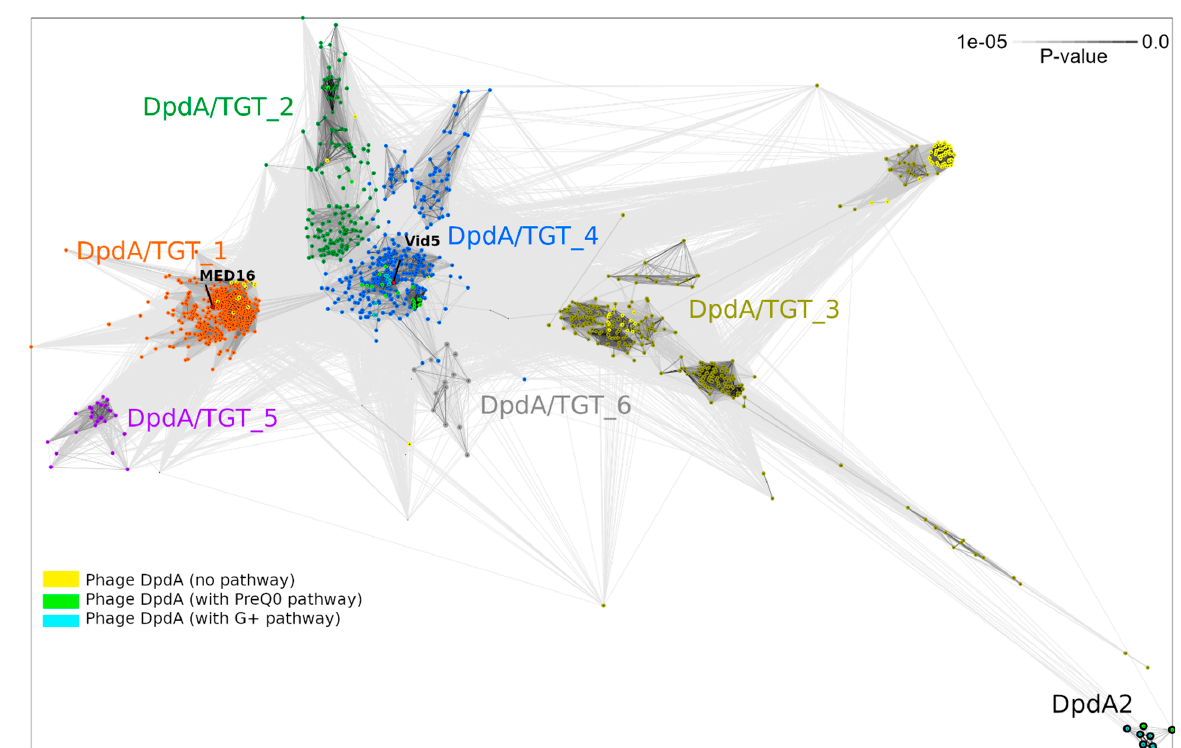
Figure 5. Pairwise comparison of DpdA/TGT proteins. Sequences were clustered and connections are shown at CLANS p -value of 1 × 10 − 5 .